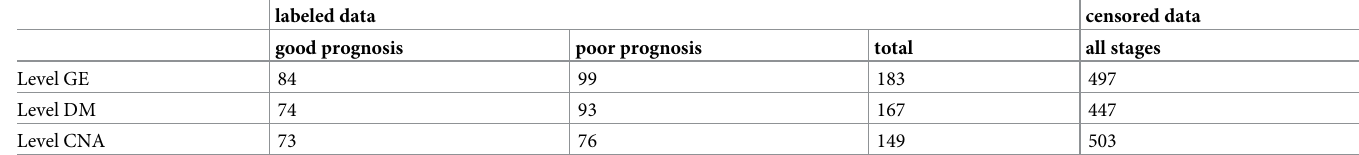
Table 3. The description of datasets. This table shows the sample sizes for labeled data (thresholds < 700 and > 1400 days) and censored data. labeled